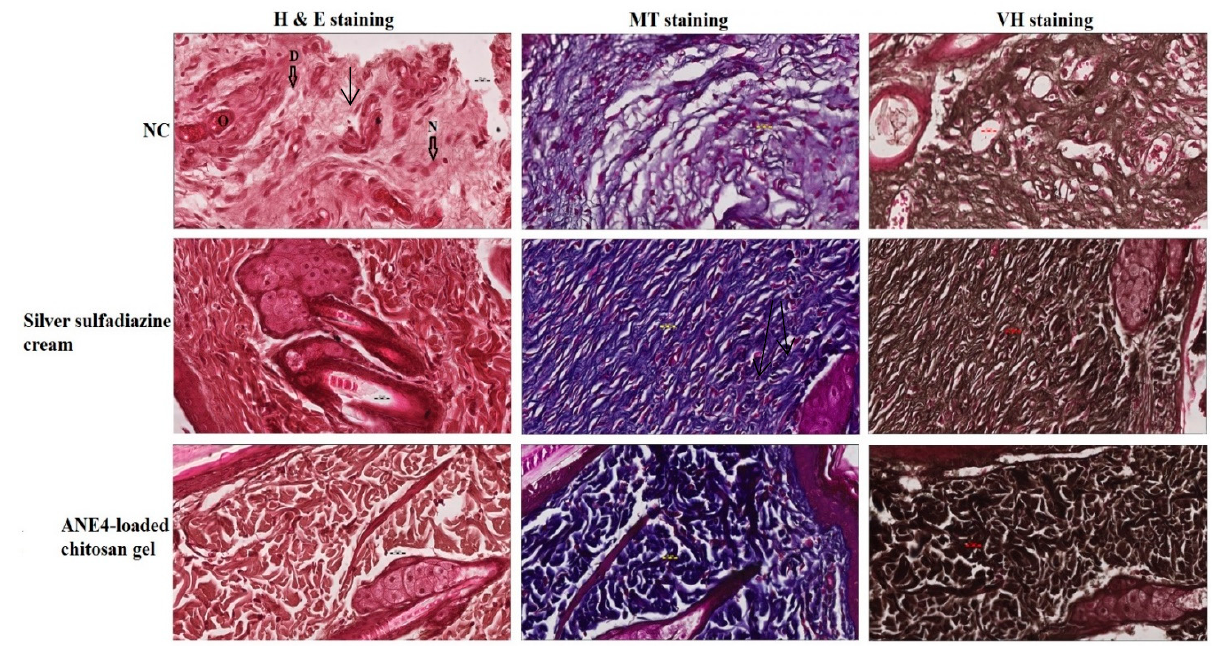
Figure 11. Photo images of skin samples after 21 days of treatment with ANE4 ‐ loaded chitosan gel and silver sulfadiazine cream with hematoxylin and eosin (H&E) stain, Masson Trichrome (MT) stain and Verhoeff hematoxylin (VH) stain (magnification 400×, and the scale bar is 20 μ m). Negative control (NC) show severe tissue damage in the form of necrosis due to absence of nuclei as only remaining dissolved nuclei (N), degeneration in the form of vacuoles (D) as well as occlusion of a blood vessel by a large spot of hyaline material (O).